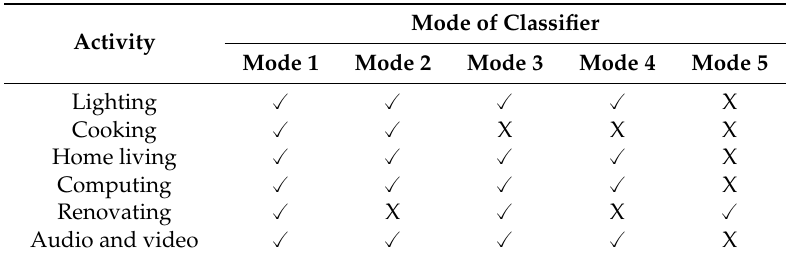
Table 4. Various Modes in GA-SVM-MKL classifier.